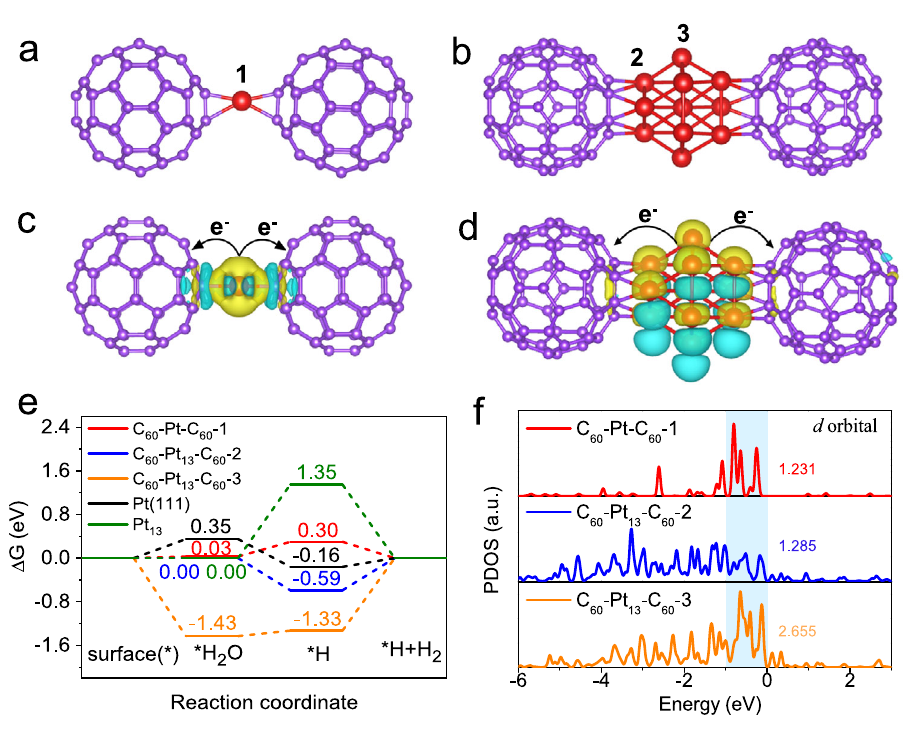
Fig. 7 | Theoretical calculationsofelectronicstructureand energy diagramfor different Pt sites. The side view of optimized model for a Pt single atom and b small Pt clusters. The charge differential density map of c C 60 -Pt-C 60 and d C 60 - Pt 13 -C 60 , blue and yellow represent electron density decrease and increase,